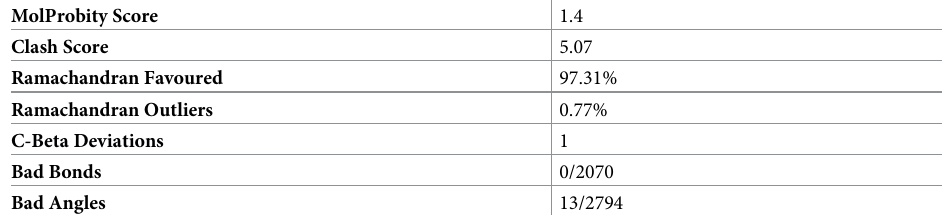
Table 6. MolProbity results to validate the SWISS-MODEL prediction for MCEE. A MolProbity Score close to 0 represents the resolution that one would see a structure of this quality. Clash score represents overlapping residues; a lower value is favored. Outliers represent values that extend outside the standard deviation; low values are also favored. Low values for bad bonds and angles are also